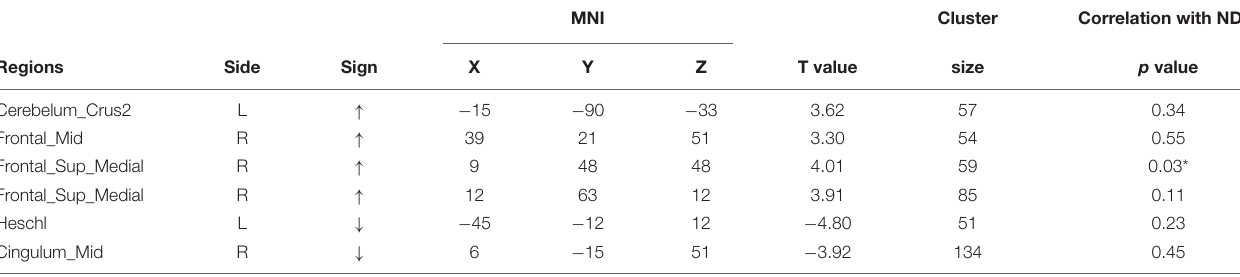
TABLE 1 | Cerebral activity changes elucidated by acupuncture treatment in all FD patients. MNI Cluster Correlation with NDSI